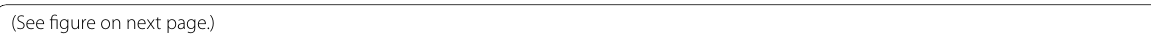
figure on next Fig. 6 Multiple amino-acid sequence alignment of the serratiopeptidase from S. marcescens AD-W2, PRZN_SERME serralysin from S. marcescens (E-15) with 100% sequence identity, PRZN_SERMA Serralysin from S. marcescens with 98.6% sequence identity, 0A240AD01_SERFI Serralysin from S. ficaria with 92.6% sequence identity, D4E064_SEROD Serralysin from S. odorifera DSM 4582 with 82.8% sequence identity and E0SC28_DICD3 Secreted protease A from Dickeya dadantii with 64.8% sequence identity. The protein sequence from serratiopeptidase was aligned to see the similarities, differences, and conservation of various amino acid residues using multiple sequence alignment. The alignment was carried out by using Clustal W platform in Seaview